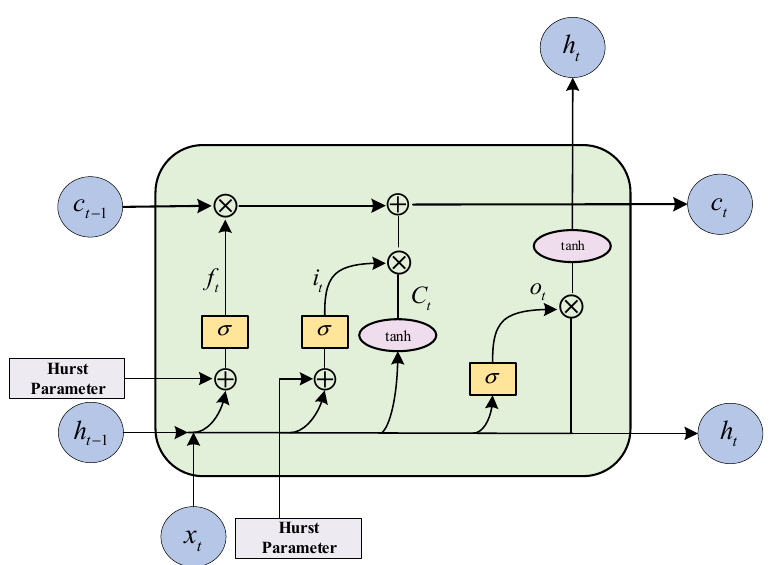
Figure 4. Schematic diagram of the LSTM structure after fusing prior knowledge. The traditional LSTM requires the value f t calculated by the sigmoid function to control the flow of the implied state from the previous step c i − 1 into the next step before calculating the next implied state c i . FPK-Net adds the Hurst exponent of the input sequence before the function transformation to improve the forget and input gates of the LSTM. The specific forget and retention values of the LSTM are controlled by the current input and the previous implicit state through the sigmoid function, such that this improved gating mechanism can be considered reasonable. From Equation (6) above, we can see that both the forget gate and input gate finally need to go through the sigmoid function output, and the output takes values between 0 and 1. When the output tends to 1, it indicates a memory state and, vice versa, when it tends to 0, it indicates a forget state. The Hurst exponent reflects the local and overall scale invariance of the traffic sequence; that is, when 0.5 < H < 1, the trend of the traffic sequence in the future time peri-od can be predicted. The larger the Hurst exponent, the higher the degree of self-similarity, which is positively correlated with the operation mechanism of the forget and input gates. Therefore, if the Hurst exponent is added before the linear transformation, it can meaningfully learn the linear transformation weights and, thus, guide traffic sequence prediction. The improved forget gate and input gate equations are as follows: